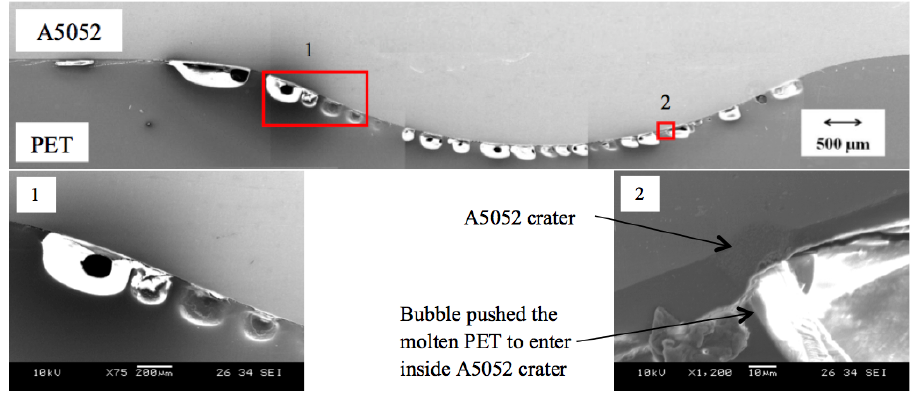
Figure 8. Cross-sectional observation of A5052(E0.5)-PET specimen joint at plunge speed of 10 mm/min and plunge depth of 0.7